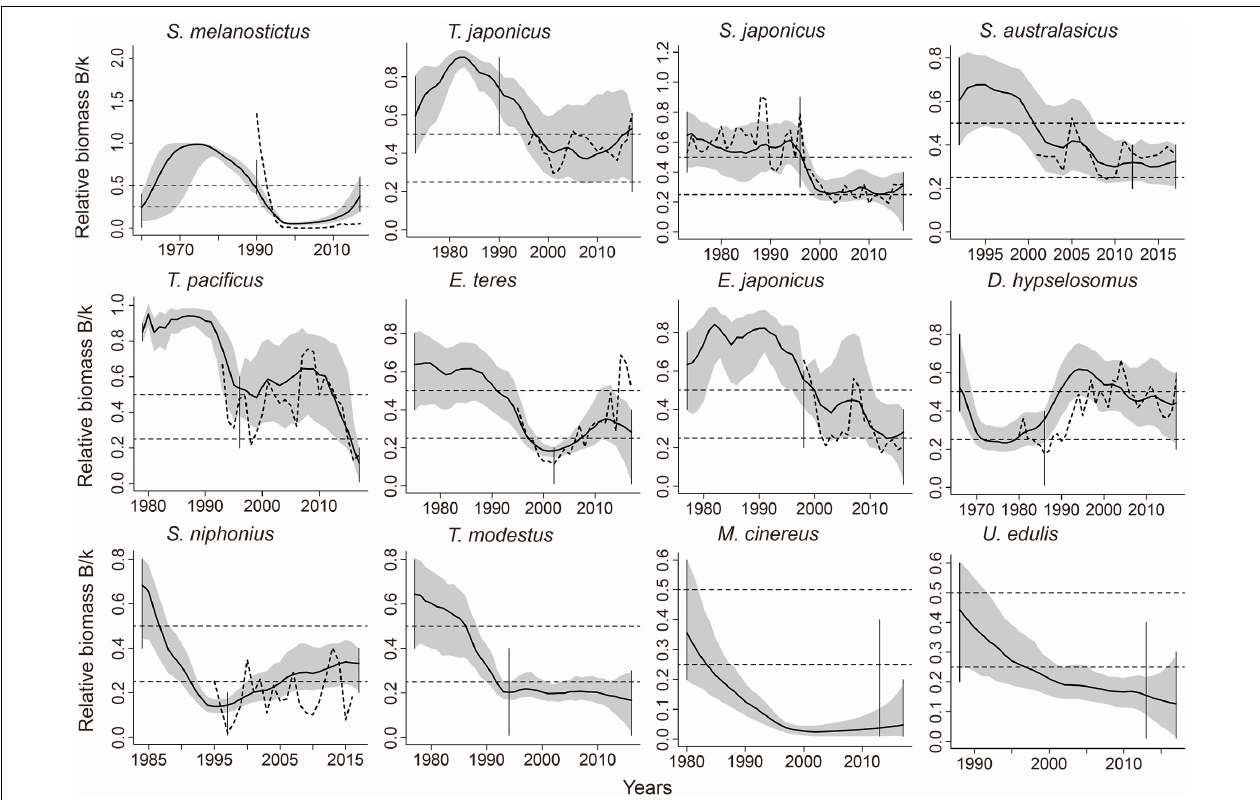
FIGURE 1 | Biomass trajectories (solid line) estimated by CMSY for 12 species in question. The gray areas showed the 95% confidence intervals of the biomass, and the dotted lines showed additional information (CPUE or SSB) when available. The three vertical lines indicated the prior biomass ranges, and two horizontal dotted lines indicated the 2.5th and 97.5th